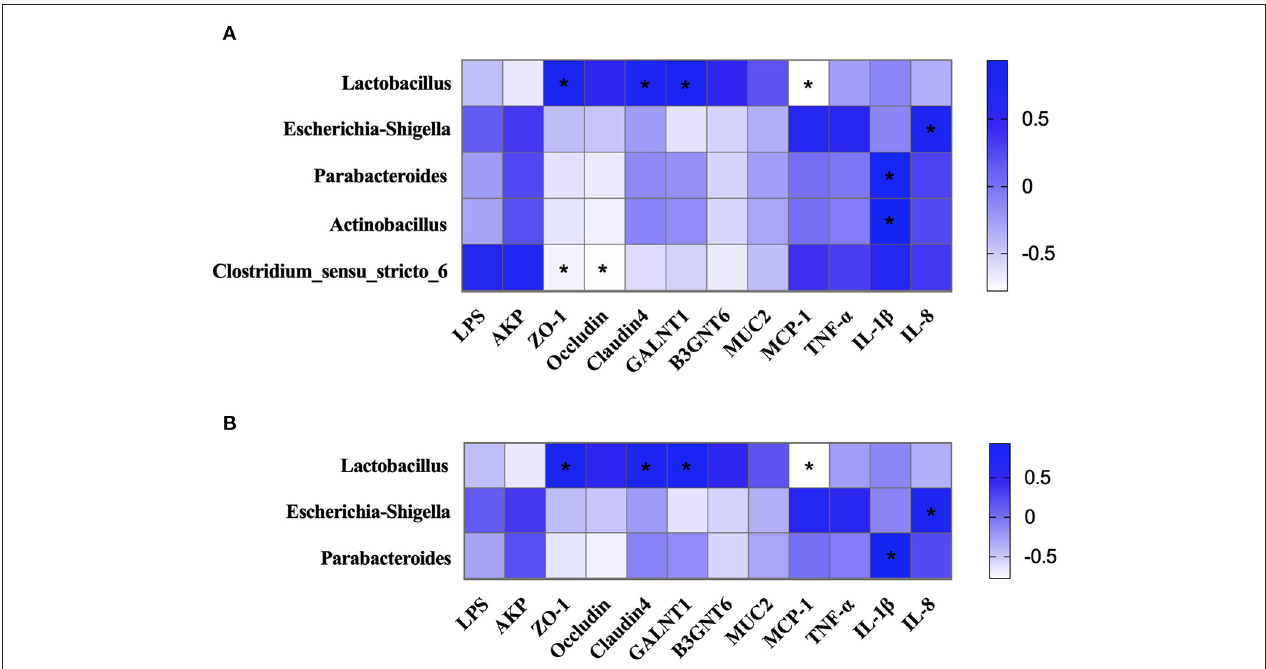
FIGURE 9 | The correlation of intestinal microbiota, intestinal barrier, and immune-related indexes. (A) The correlation of intestinal microbiota, intestinal barrier, and immune-related indexes in colonic chyme. (B) The correlation of intestinal microbiota, intestinal barrier, and immune-related indexes in colonic mucosa. * P < 0.05.